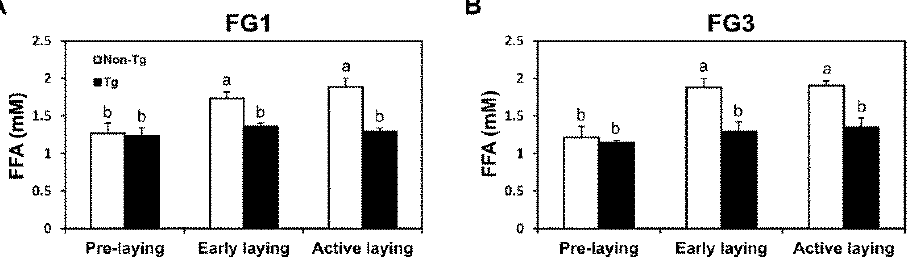
Figure 3. Lipolytic activity due to egg laying is lowered by G0S2 overexpression. Blood NEFA levels of ( A ) line FG1 and ( B ) line FG3 non-transgenic and transgenic quail at different stages of laying ( n = 5 per group per time point). Bars represent mean ± SEM. Bars that share the same superscript letter are not significantly different from each other ( p < 0.05).